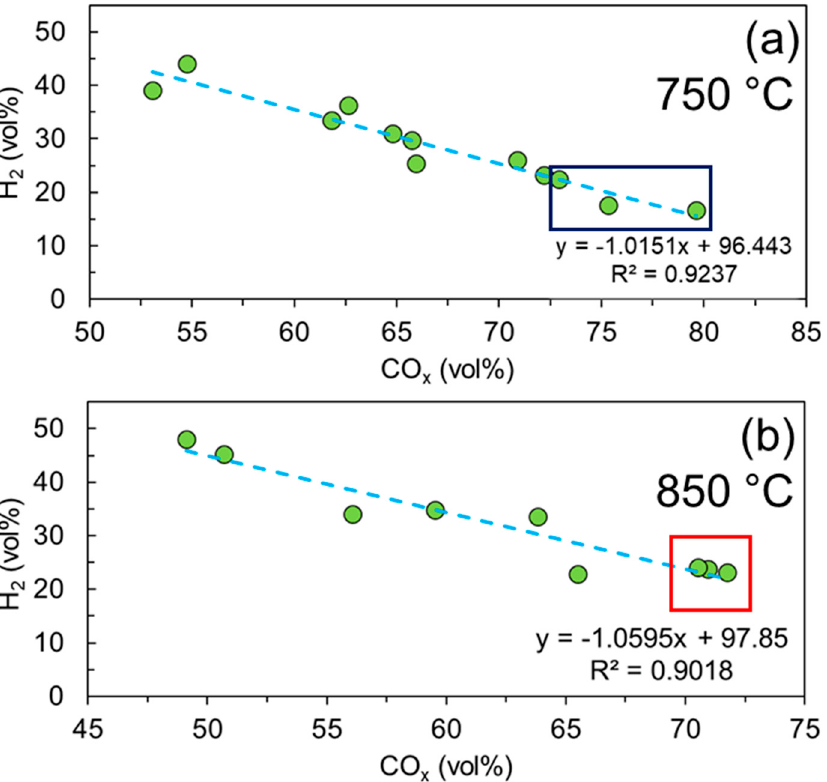
Figure 4. Correlation between hydrogen and carbon oxides at two different gasification temperatures: ( a ) 750 °C (dark blue square indicating LP 17 CM 83 ) and ( b ) 850 °C (red square indicating LP 48 CM 52 ), for all experimental mixtures and conditions.